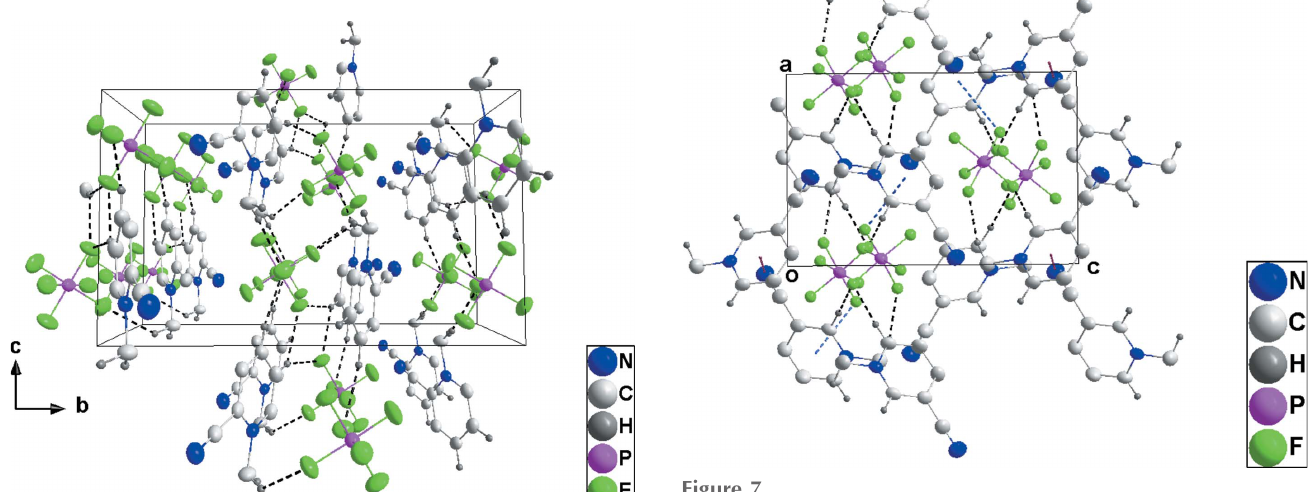
Figure 7 Packing of 2 viewed along the b -axis direction. C—H (cid:2)(cid:2)(cid:2) F hydrogen